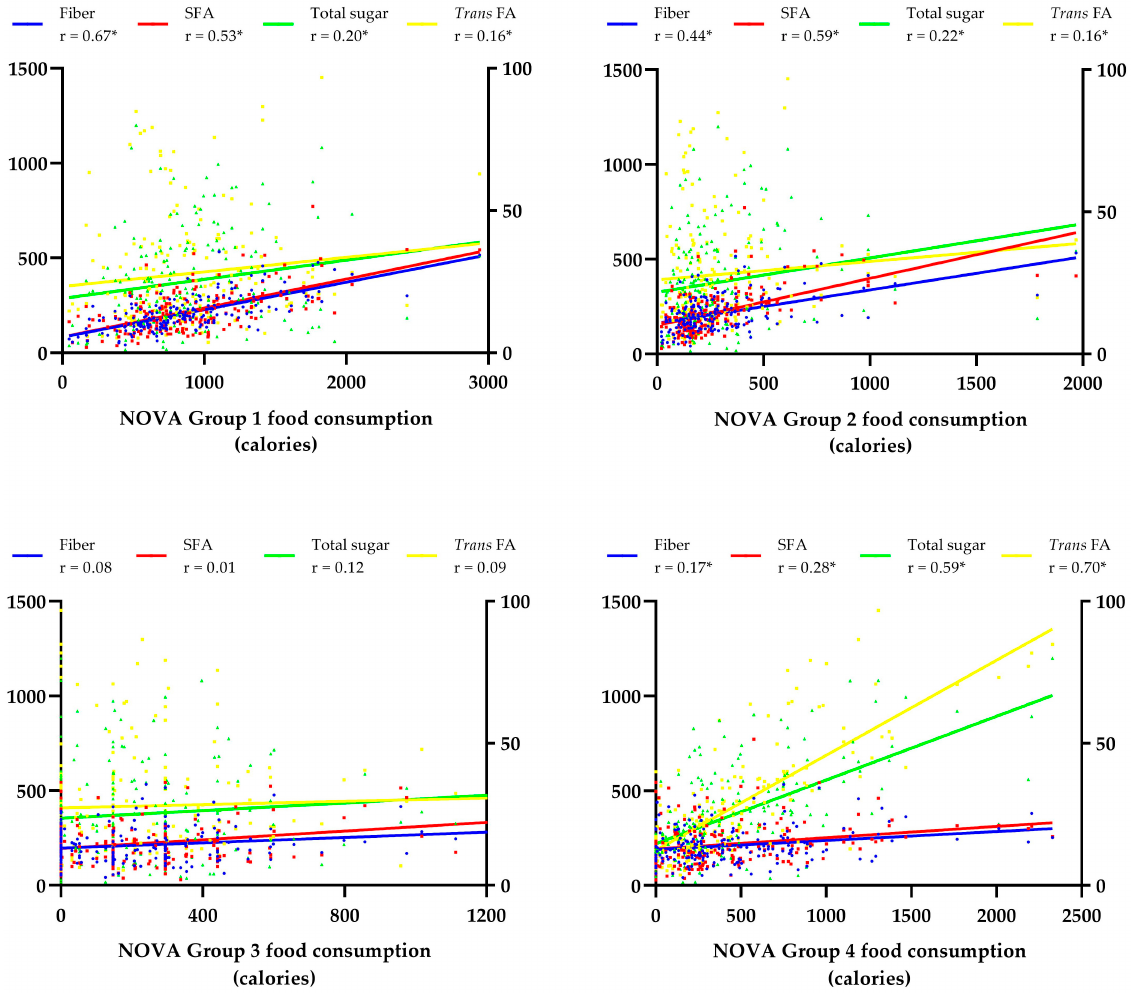
Figure 1. Correlation between food consumption according to levels of processing and macro- and micronutrient intake. Statistical test: Spearman correlation. * Statistically significant differences ( p < 0.05). Left Y-axis: Fiber (g); SFAs—Saturated Fatty Acids (calories); total sugar (calories). Right Y-axis: Trans FAs— Trans Fatty Acids (calories). NOVA—Group 1 (unprocessed food); Group 2 (processed culinary ingredients); Group 3 (processed food); Group 4 (ultra-processed food). Spear- man r classification—very weak (0.00 to 0.19); weak (0.20 to 0.39); moderate (0.40 to 0.69); strong (0.70 to 0.89); very strong (0.90 to